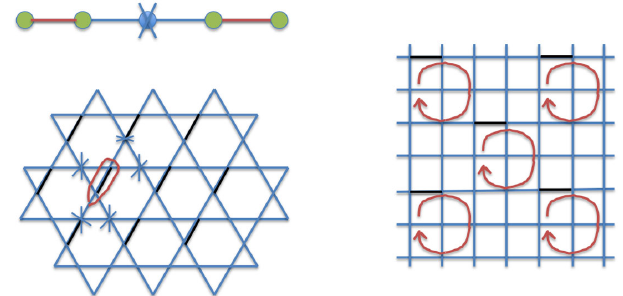
FIG. 13. Upper left: the measurement protocols require the bonds (red) between unmeasured sites (green) to be separated by at least two edges. This allows for at least one measured site (crossed) between them. Lower left: the naive attempt to perform the measurement protocol on the kagome lattice does not work because two of the surrounding measured sites around the unmeasured sites (circled with red) overlap with other unmeas- ured sites (denoted as the ends of black links). Right: An example of a measurement protocol on a square lattice that satisfies the requirement that the edge distance between unmeasured pairs must be at least 2. If the unactivated (always measured) sites in this protocol are removed, we have exactly the eight-step protocol on a Lieb lattice introduced in this